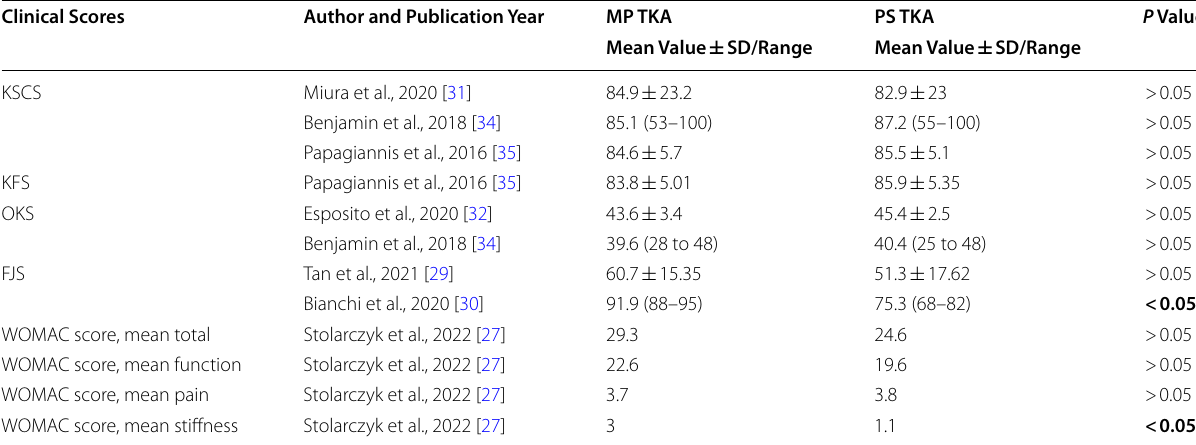
MP Medial pivot, PS Posterior stabilised, SD Standard deviation, KSCS Knee Society Clinical Score, KFS Knee Functional Score, OKS Oxford Knee Score, FJS Forgotten Joint Score, WOMAC score Western Ontario and McMaster Universities Arthritis Index